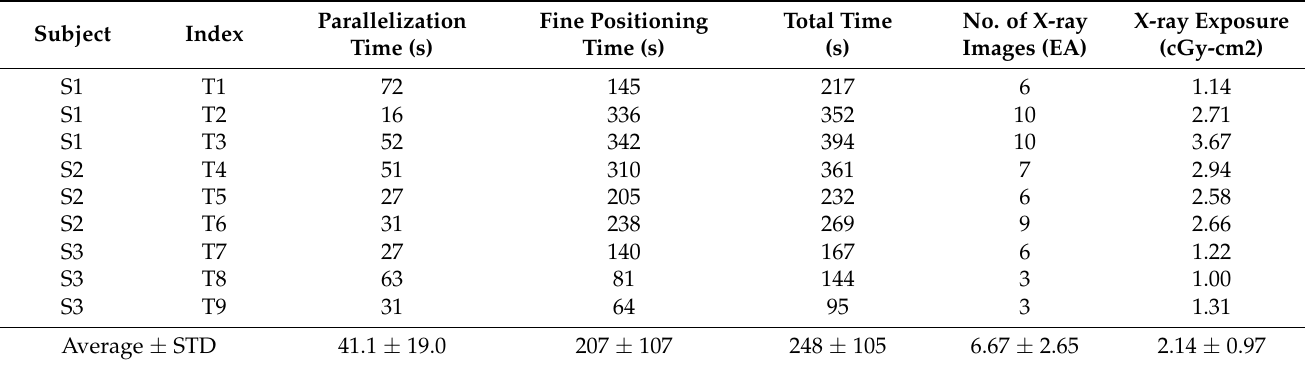
Table 1. Measured parameters during experiments.